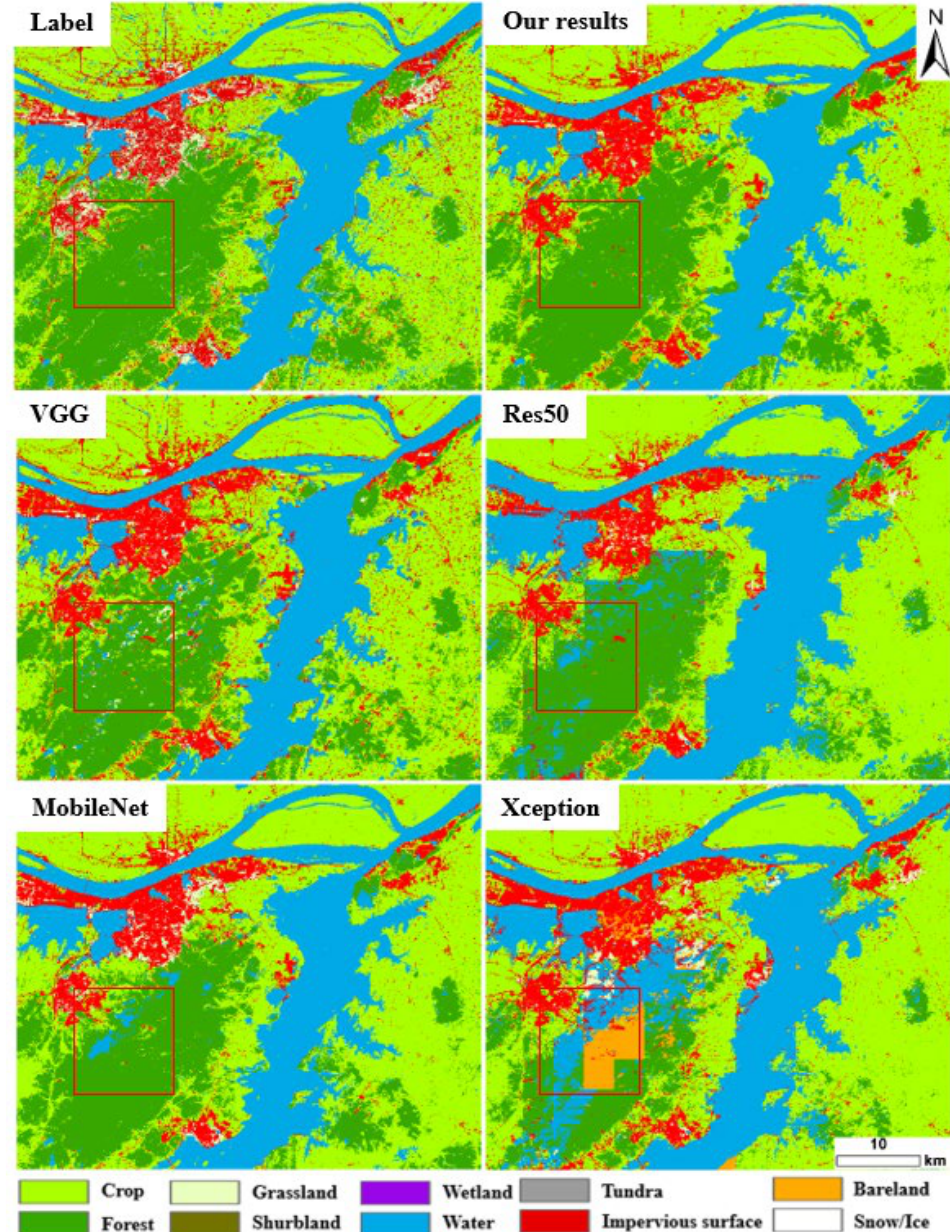
Figure 4. Results of different networks for large scale mapping in Jiujiang. During the training process, both RGB and NGB enter convergence faster and the accuracy continues to improve. In contrast, NRGB starts the training with a large fluctuation in loss and soon fails to continue the improvement. It can be seen that having a lot of spectral features does not necessarily improve the performance of the model, and the replacement of the red band with NIR can effectively improve a part of the model’s performance in medium-resolution remote sensing segmentation. In addition, multi-channel input images are not accessible to many classical three-channel image enhancements (e.g., HSV conversion), which is partly responsible for